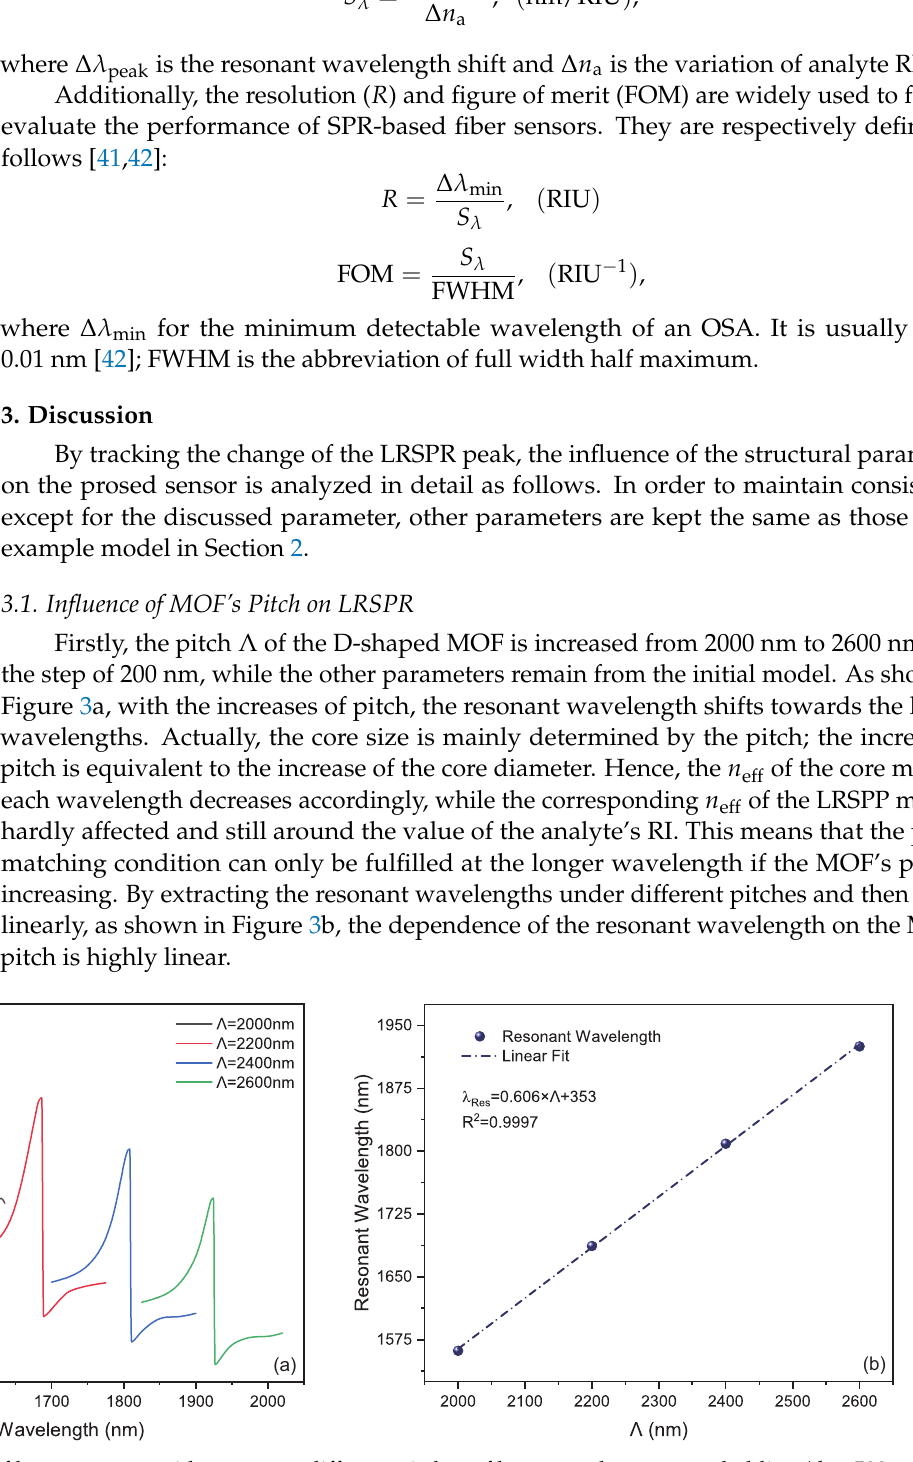
Figure 3. ( a ) The variation of loss spectrum with respect to different pitches of honeycomb structure cladding ( d = 500 nm, = 150 nm, t = 70 nm, t = 3 nm, n a = 1.33). ( b ) The resonant wavelength and the corresponding linear fitting t SiO Au TiO 2 2 under different pitches of honeycomb structure